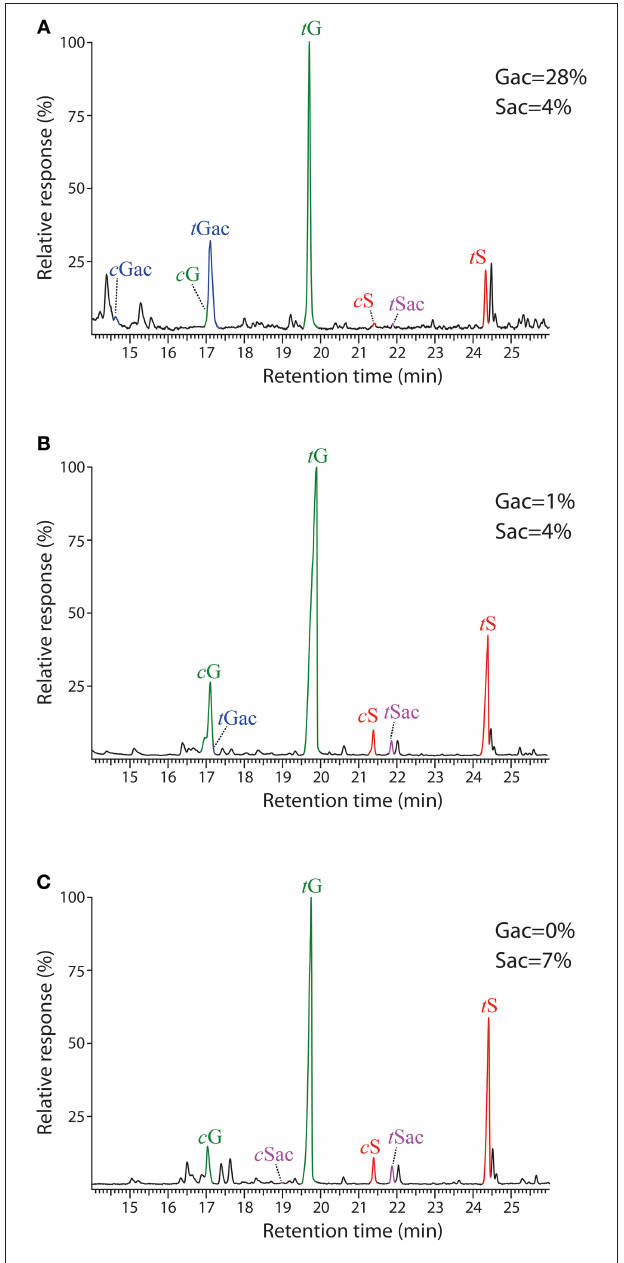
FIGURE 6 | Chromatograms of the DFRC ′ degradation products from the milled lignin preparations isolated from the different parts of Q. suber (A) cork, (B) phloem, and (C) xylem. c G, t G, c S, and t S are the normal cis - and trans -coniferyl (guaiacyl) and sinapyl (syringyl)